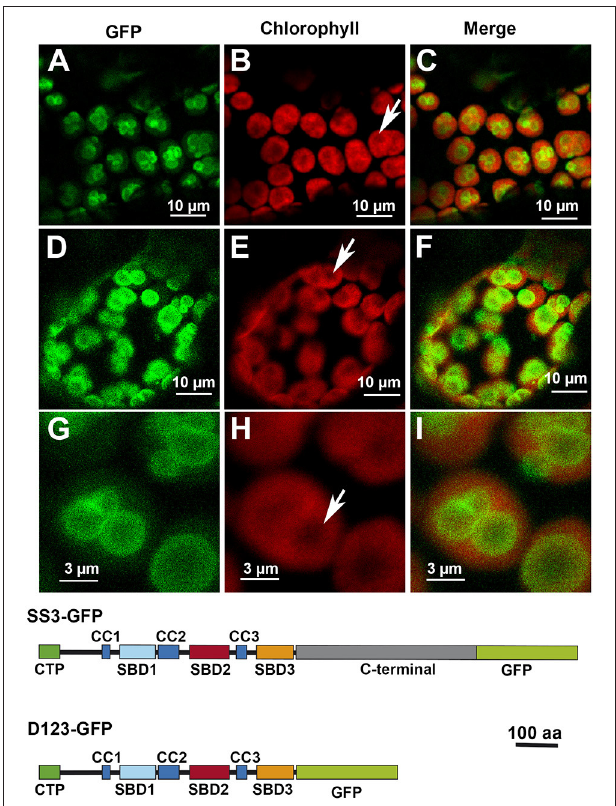
FIGURE 2 | Localization of full-length AtSS3 (A–C) and the N-terminal region of AtSS3 (D–I) fused to GFP in Nicotiana benthamiana chloroplasts. GFP column: fluorescence of the GFP marker. Chlorophyll column: autofluorescence of the chlorophyll. Merge column: merged images of previous columns. Bottom: structures of the constructs fused to GFP. SS3-GFP: full-length AtSS3 fused to GFP. D123-GFP, N-terminal region of AtSS3 fused to GFP. The white arrows indicate the presence of a starch